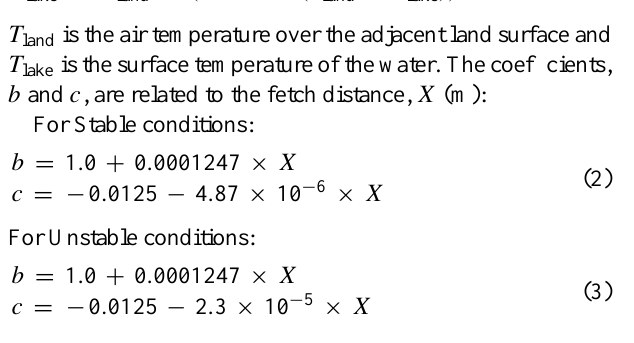
Figure 2. The observed relationship between the hourly evaporation over Crean Lake, 2006, and (a) net radiation, (b) wind speed, (c) land-lake temperature contrast, and (d) lake-land vapour pressure contrast.